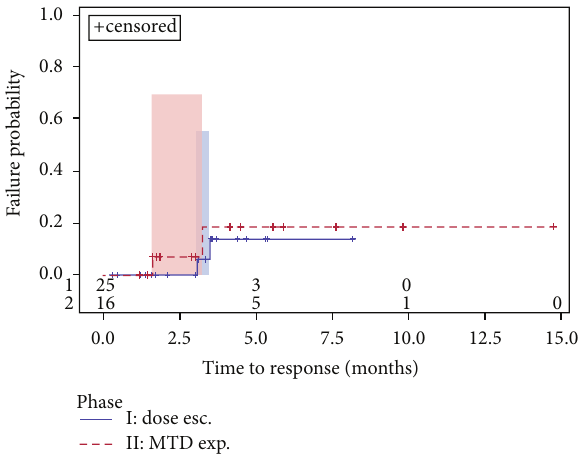
Figure 3: Time to response for phase I and phase